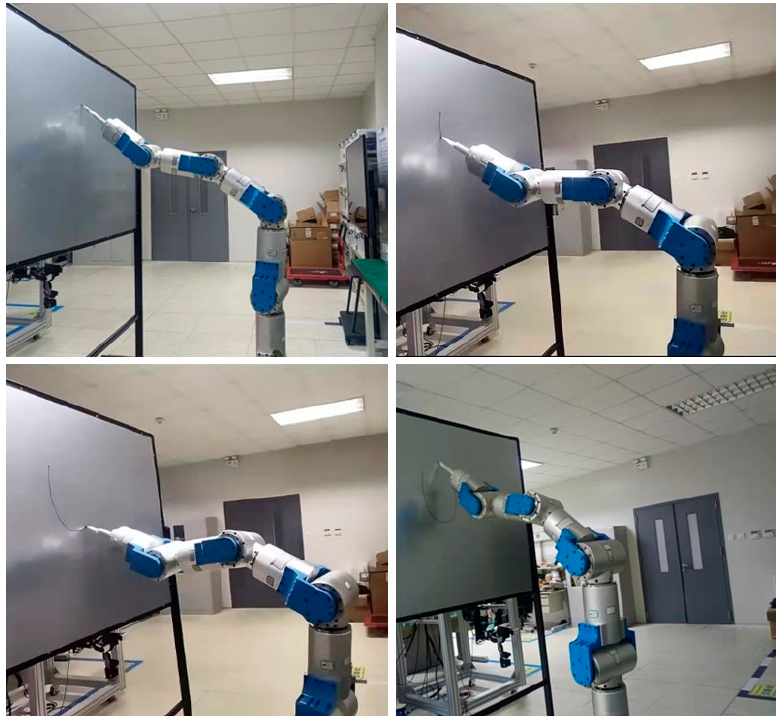
Figure 9. The experimental results of the PI-HGSO.